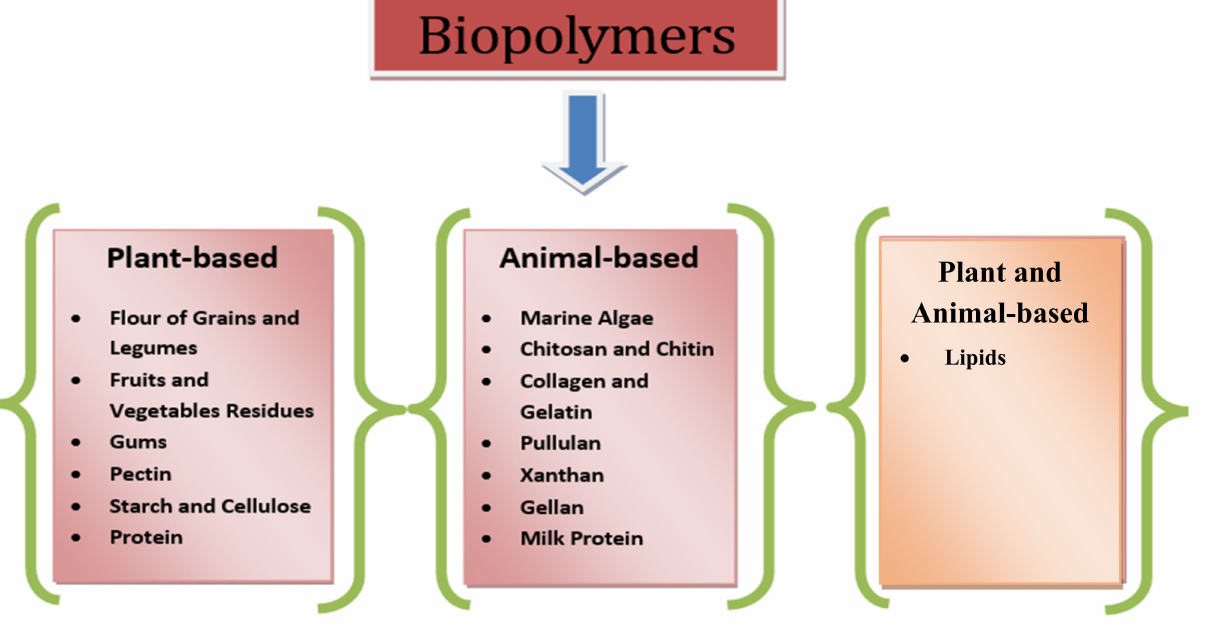
Figure 1. Different sources of